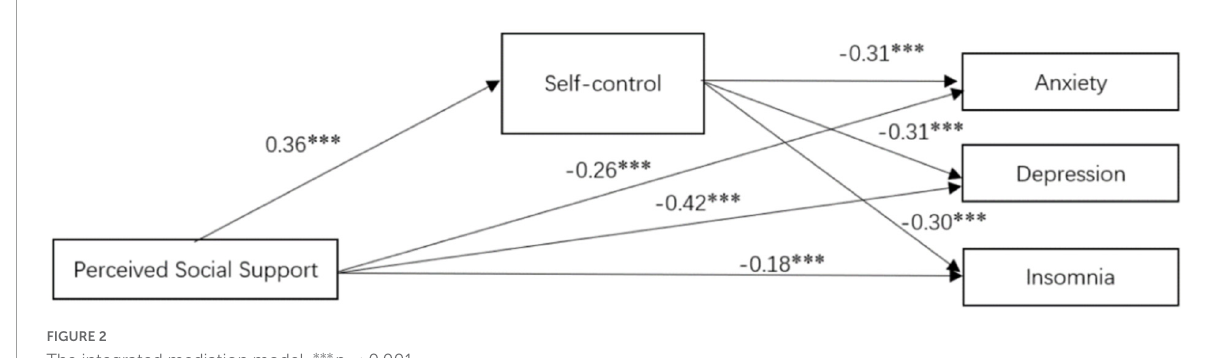
FIGURE2 The integrated mediation model. ∗∗∗ p < 0.001.